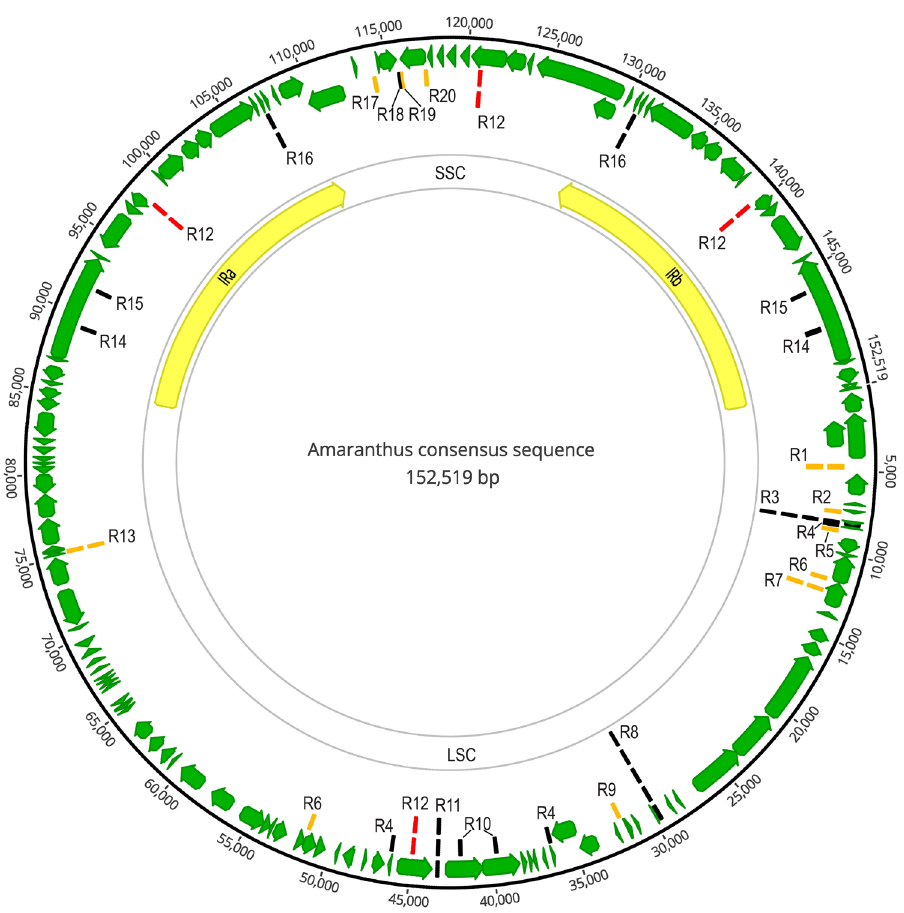
Figure 2. The distribution of repeat sequences at 30 loci in Amaranthus . “R” is short for repeat. The red line segment R12 and the black line segments are repeats in all 17 species, the orange line segment represents a repeating sequence in some species. A repeat with only one line segment indicates that there is only one repeat at the site, and vice versa indicates that there are several different repeats at the site. The chloroplast genome figure was generated by the Geneious Prime v. 2020.1.2